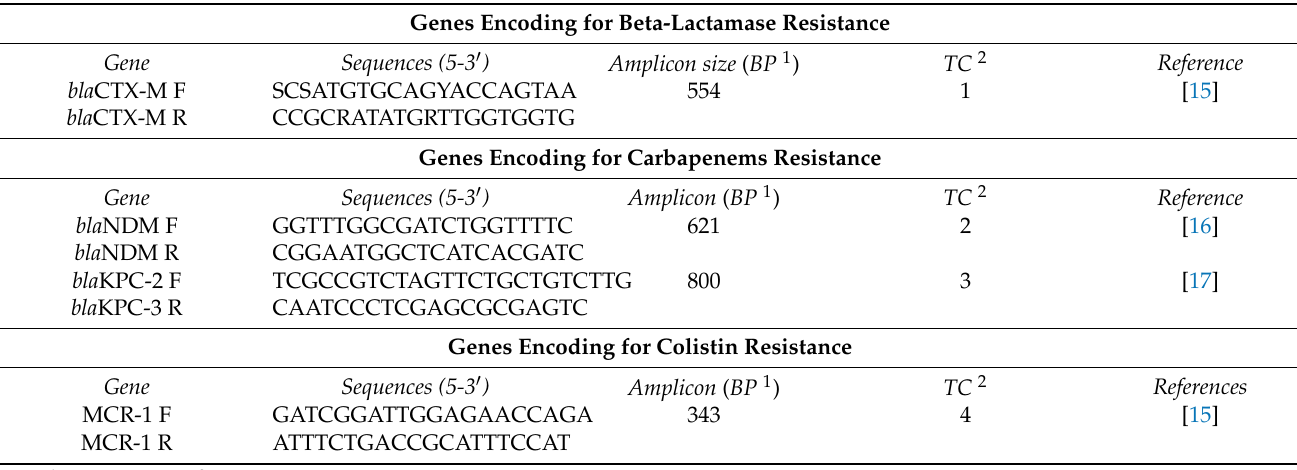
Table 2. Oligonucleotide primers and thermal cycling conditions used in the PCR assays targeting genes conferring resistance against beta-lactamase (CTX-M), carbapenems (NDM and KPC) and colistin (MCR-1). Genes Encoding for Beta-Lactamase Resistance